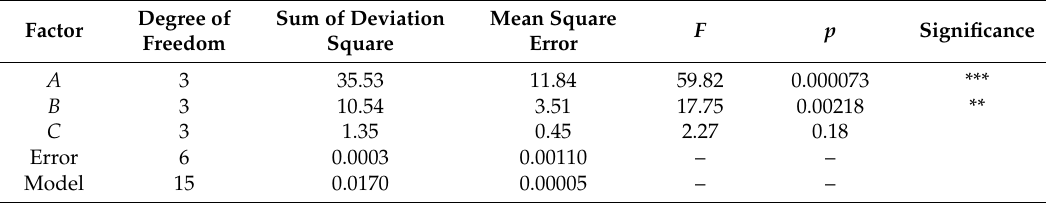
Table 5. Significance analysis for the factors affecting the impact strength.